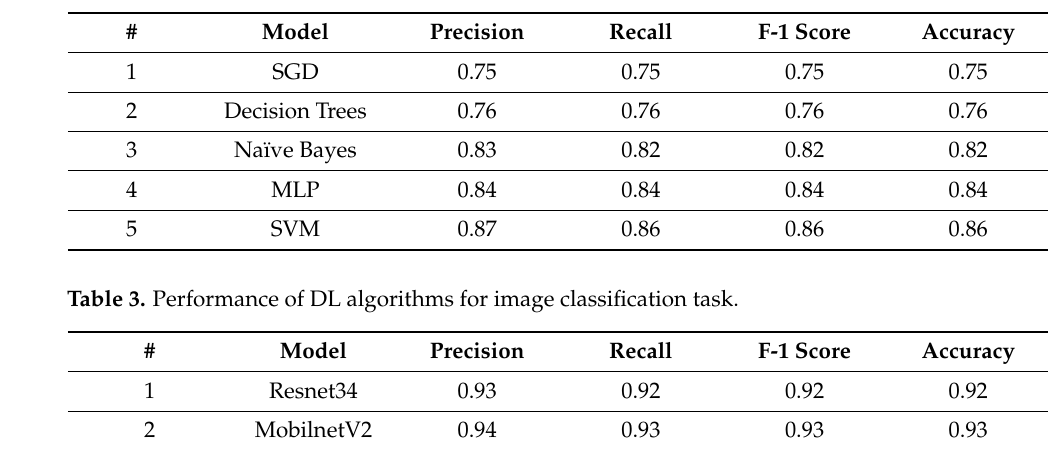
Table 2. Performance of ML algorithms for image classification task.